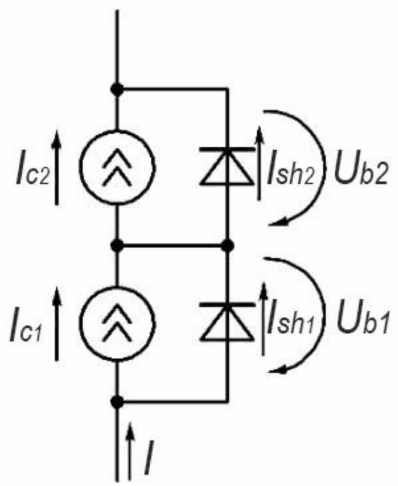
Figure 2. Switching on shunt diodes with PV